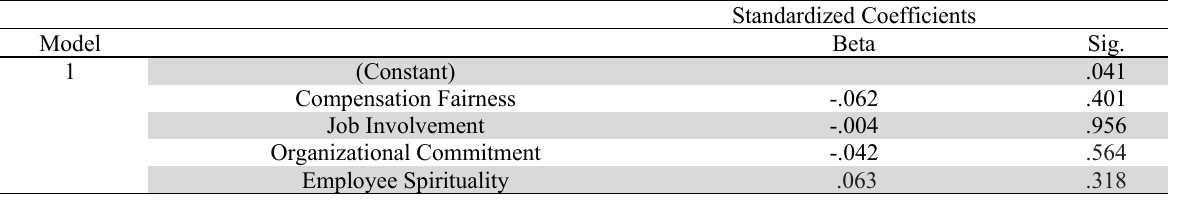
Heteroscedacity Test (Park Test)